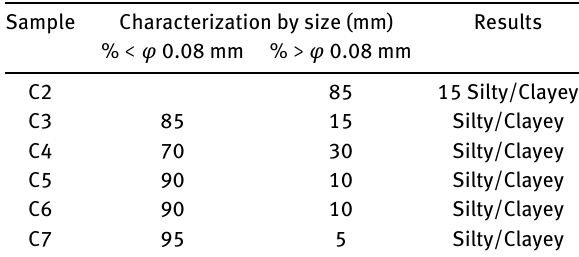
Figure 4: Samples granulometric characterization tests.